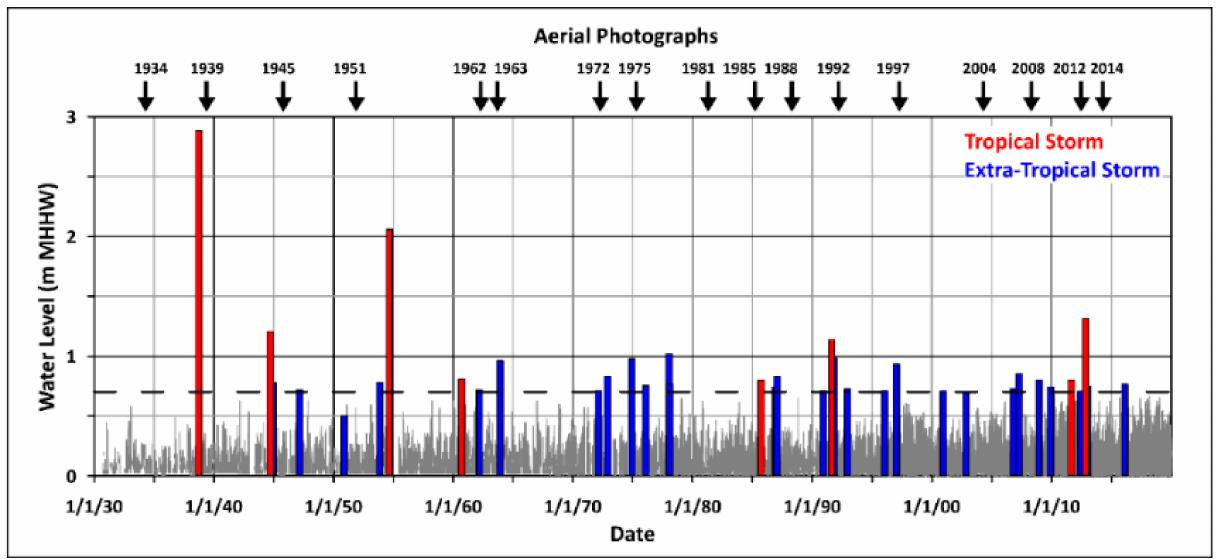
Figure 4. Water elevation levels for notable storms discussed in this study. The gray lines represent the hourly water levels at the Newport, RI tide gauge (Figure 1) [61]. The dashed black line is the threshold for storm detection used in this study (0.7 m MHHW). Red bars represent tropical storms; blue represent extra-tropical storms. Black arrows show the dates of aerial photographs (Figure S6; supplemental